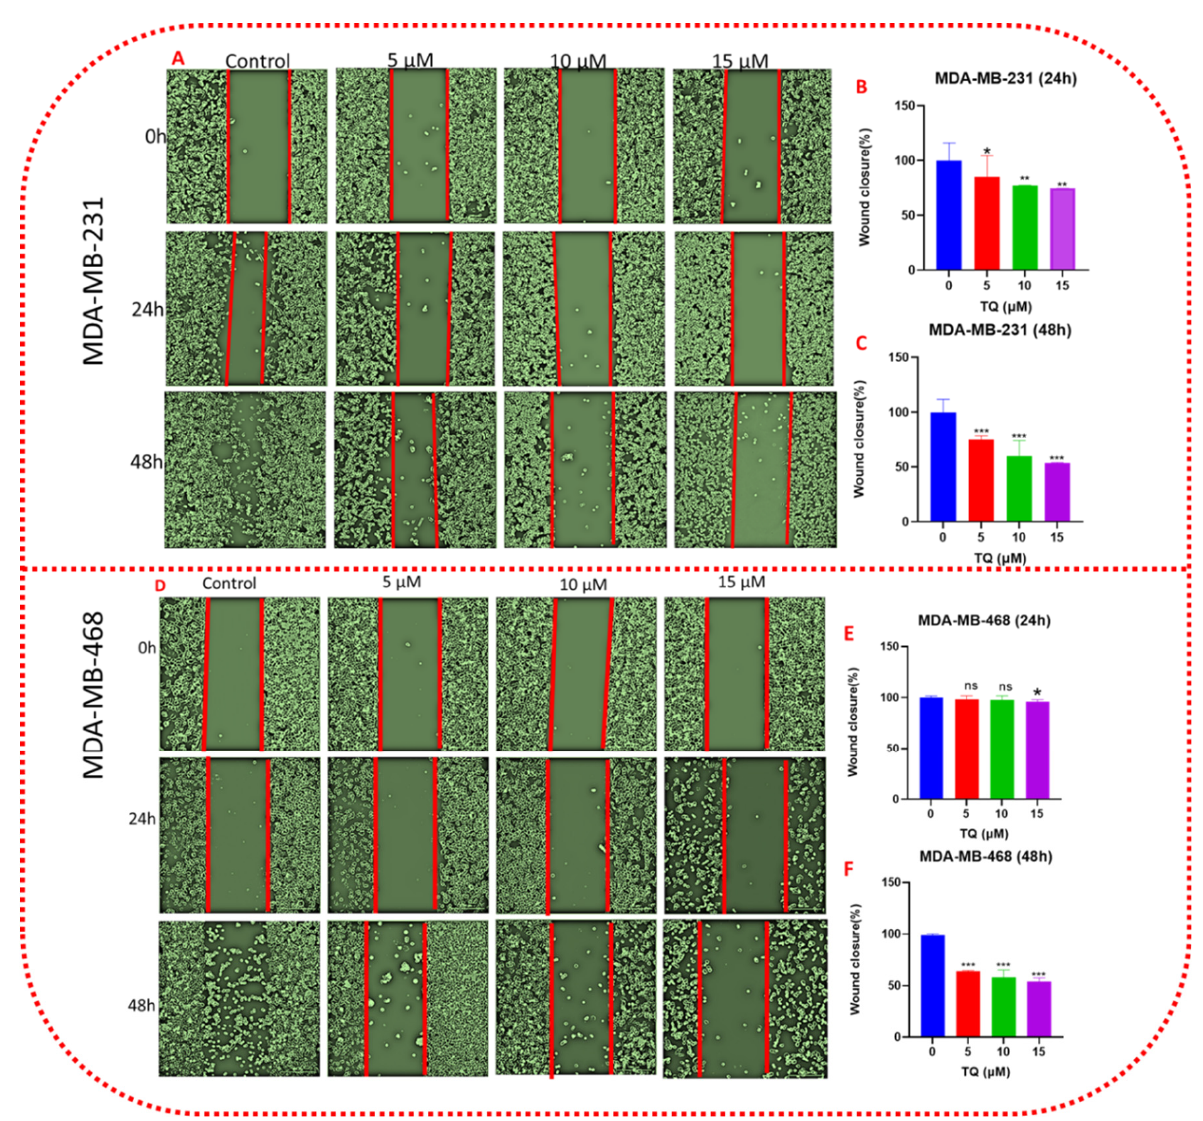
Figure 5. TQ attenuates TNBC cell migration. Figure 5 ( A – F ) shows a graphical representation of the wound-healing assay after 24 and 48 h in control and treated samples. Cell migration was assessed in MDA-MB-231 and MDA-MB-468 after exposure to TQ at concentrations of 0, 5, 10, and 15 µM. Both cells were treated with TQ for 24 h, and migration was assessed using a wound-healing assay in a 12-well plate (as described in Section 2). MDA-MB-231 ( A ) and MDA-MB-468 ( D ) typical phase-contrast pictures of the wound site of control and TQ-treated cultures at 0, 24, and 48 h after treatment. The bar graph presents the concentration–response curves of TQ-treated or control cultures at 24 h and 48 h after processing in ImageJ software, as well as the residual wound area of percent fold change in the wound closure area, ( B , C ) (MDA-MB-231), and ( E , F ) (MDA-MB-468). Data presented as the mean ± SEM of three independent experiments, each performed in triplicates, were analyzed using Student’s t -test, * p < 0.05, ** p < 0.01, *** p < 0.001, ns-nonsignificant). All scale bars indicate 300 µm in 10× magnification.